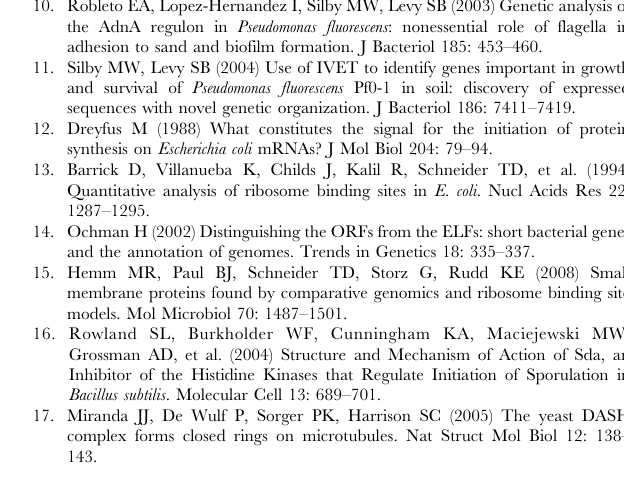
Figure S2 Alignment of Nov proteins with putative proteins identified using TBlastN. Alignments were generated with ClustalW2 (http://www.ebi.ac.uk/Tools/clustalw2/index.html ). Full start codon to stop codon sequences in each genome were determined by examining the sequence in the Artemis genome browser (http://www.sanger.ac.uk/Software/Artemis/). Found at: doi:10.1371/journal.pone.0008455.s002 (0.13 MB Table S1 Primers used in RT-PCR Found at: doi:10.1371/journal.pone.0008455.s003 (0.06 MB